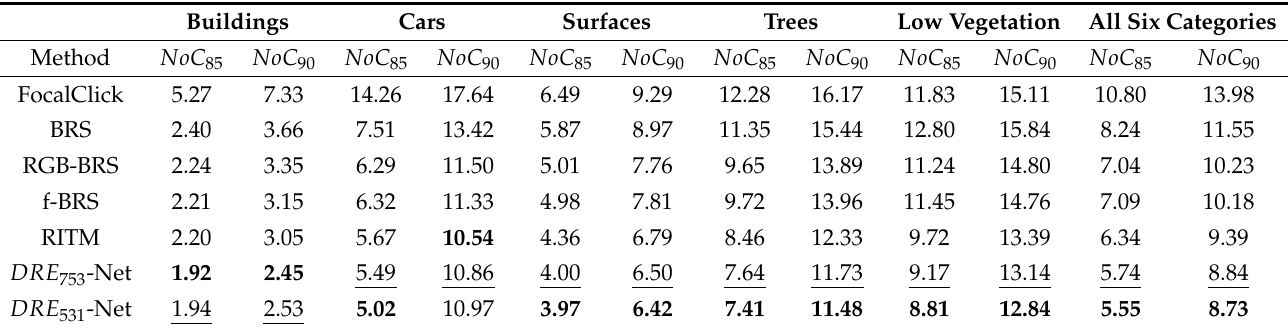
Table 3. Comparison of the NoC 85 and NoC 90 on the Vaihingen dataset. (The best is bolded and the runner-up is